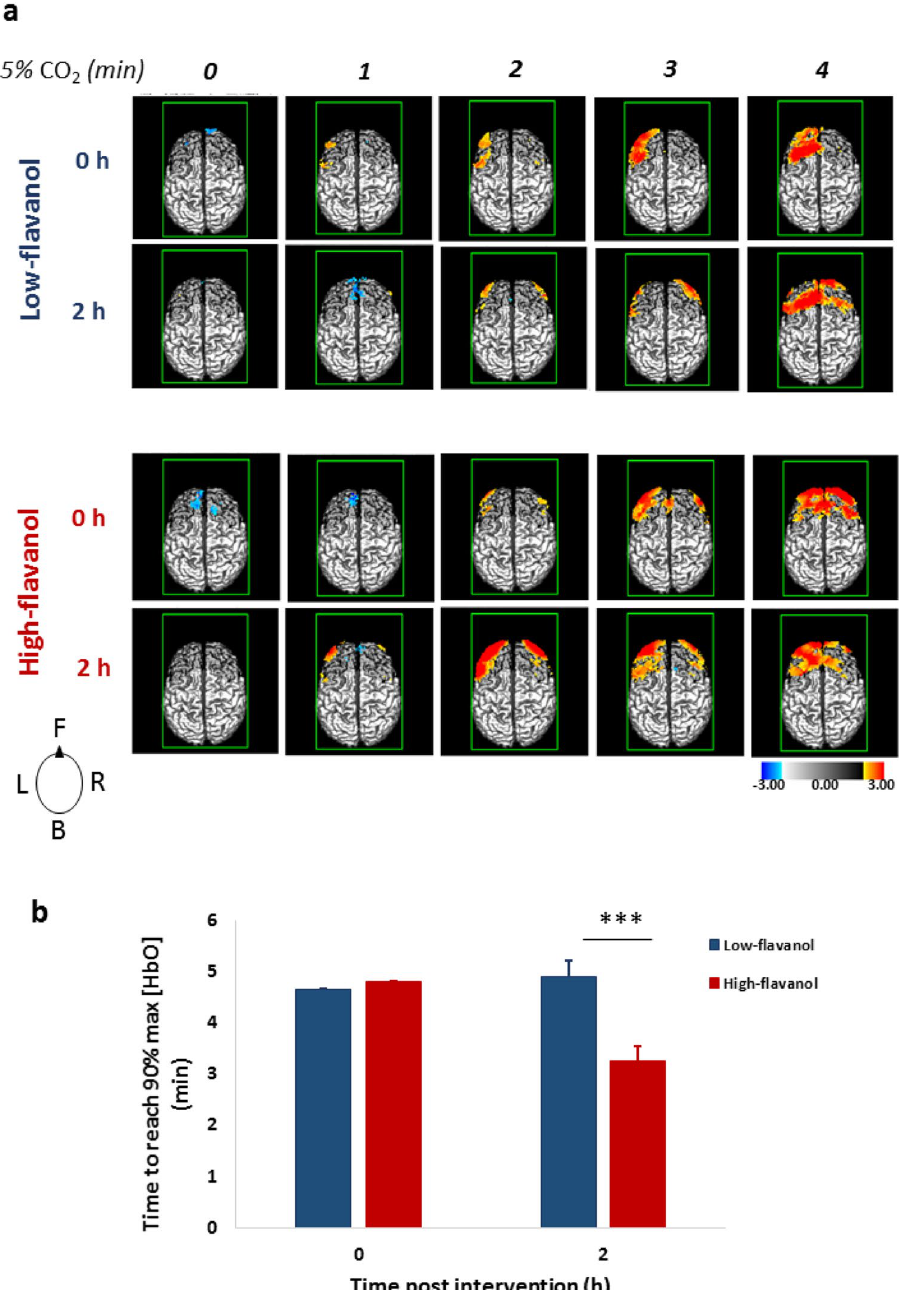
Figure 2. Brain maps of oxygenated haemoglobin during hypercapnia (5% CO 2 ) both before (0 h) and after (2 h) intake of either a low- or high-flavanol dietary intervention. ( a ) Oxy-haemoglobin concentration changes (in z scores) across frontal cortical regions and averaged across participants (N = 17) are presented at the time of onset (0 h) and 1, 2, 3, and 4 min into the CO 2 challenge. Brain maps, viewed from the top, are oriented as indicated in the inset diagram: F = front, B = back, L = left, R = right; Darker grey background color indicates the recording area. ( b ) Latency to reach 90% maximal blood oxygenation was significantly lower (*** p < 0.001) by approximately 1 min after the high-flavanol intervention in comparison to low-flavanol (Mean ±